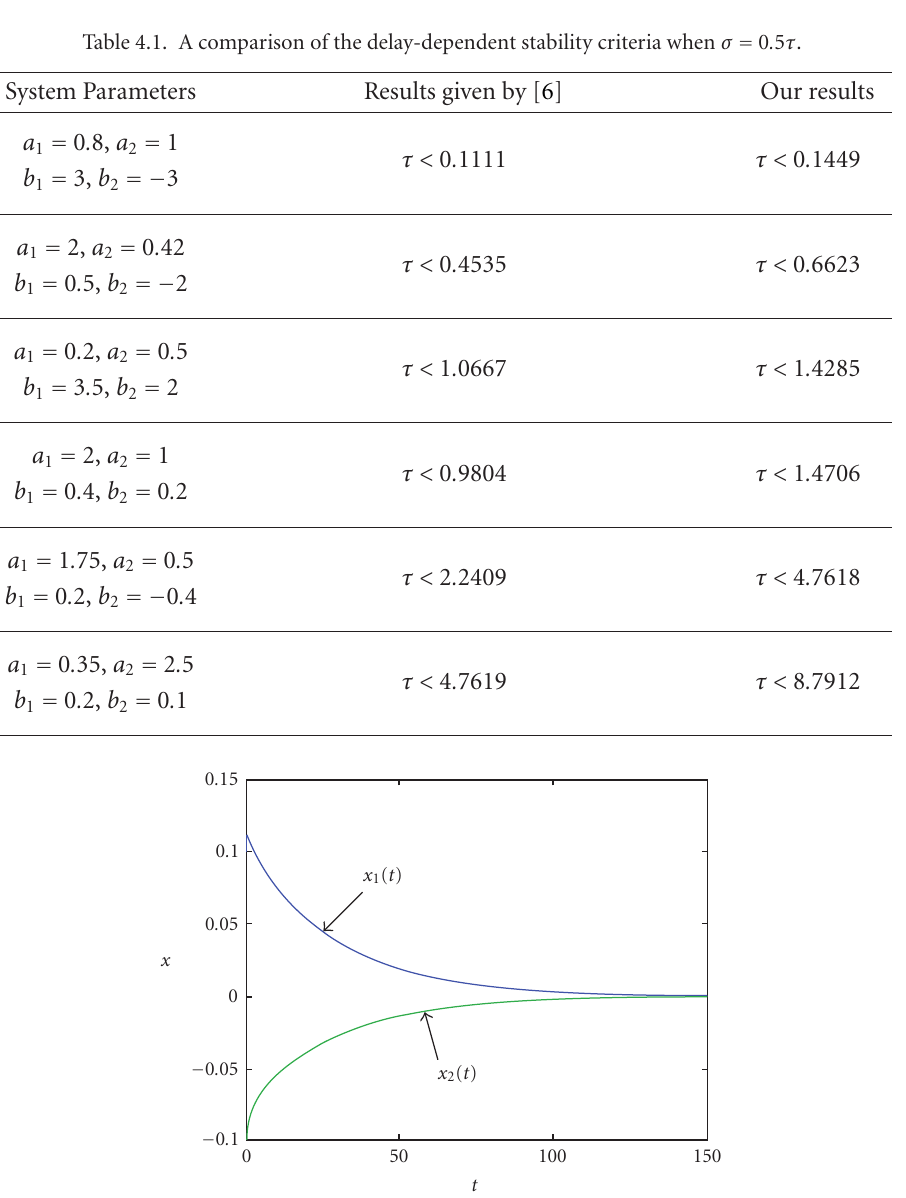
Figure 4.2. Time response of state variable for system (4.1) under a 1 = 1 . 75, a 2 = 0 . 5, b 1 = 0 . 2, b 2 = − 0 . 4, τ = 2 . 24, σ = 0 . 5 τ